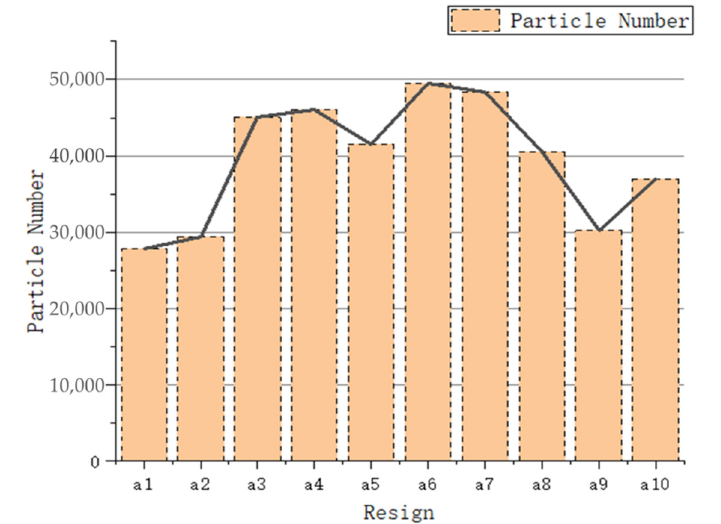
Figure 15. Thermal map of particles distribution in a10. Figure 16. Number of particles in a1~a10. Figure 16. Number of particles in a1~a10.